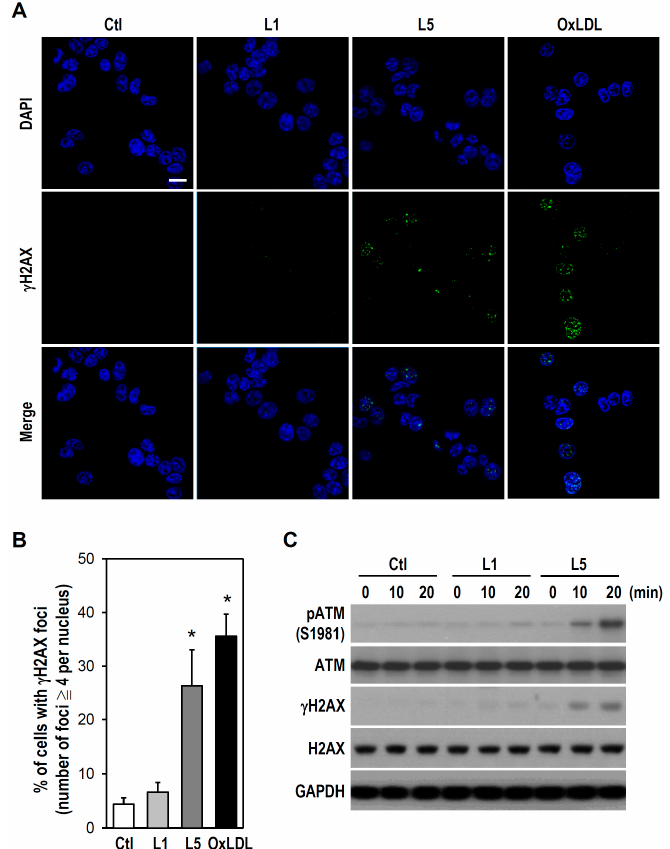
Figure 3. L5 induces ATM phosphorylation and formation of γ H2AX foci in cultured PC12 cells. ( A ) Representative immunofluorescence images of γ H2AX foci are shown. Cells grown on coverslips were treated with the indicated LDL (30 μ g/mL) for 30 min. Untreated cells were used as a control. Immunostaining was performed using an antibody against γ H2AX (green). Cells were counterstained with DAPI to recognize the nucleus (blue). Scale bar = 10 μ m; ( B ) The histogram shows the quantification of ( A ). At least 20 randomly selected fields for each treatment group were examined. Cells with ≥ 4 γ H2AX foci per nucleus were regarded as positive and then scored. Value expressed as a percentage by calculating the number of positive cells (% of total). Data are presented as mean ± SEM from four independent experiments. * p < 0.05 vs. Ctl; and ( C ) After treating the cultures with L1 or L5 at 30 μ g/mL for different times as indicated, western blotting was performed to detect pATM, ATM, γ H2AX, and H2AX expression. GAPDH was a protein loading control. Representative blots selected from one of four independent experiments are presented.